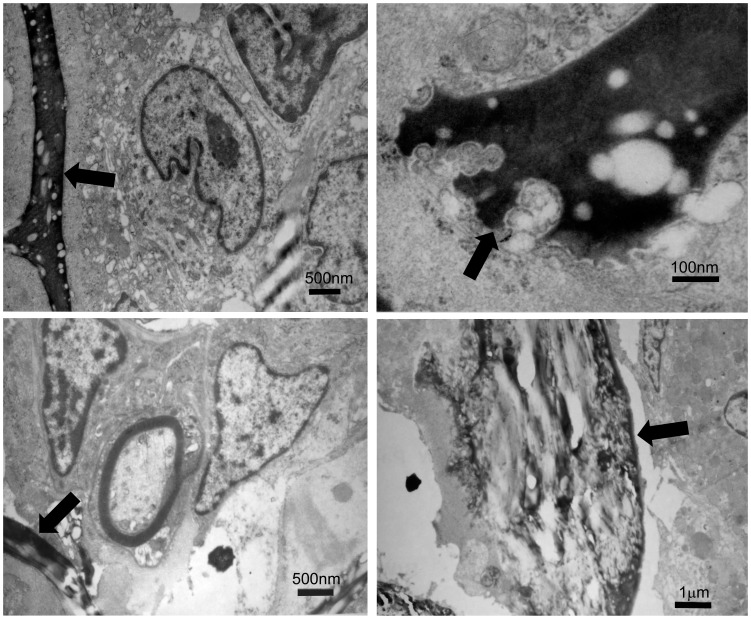
The morphological characteristics of the grafts at 4 w (A, B) and 8 w (C, D) after its in vivo implantation.The graft was degraded over time. At 4 w after implantation, the graft showed worm-eroding structures as indicated by black arrows (A, B). At 8 w after implantation, some of the graft degraded into pieces which were indicated by black arrows (C, D).